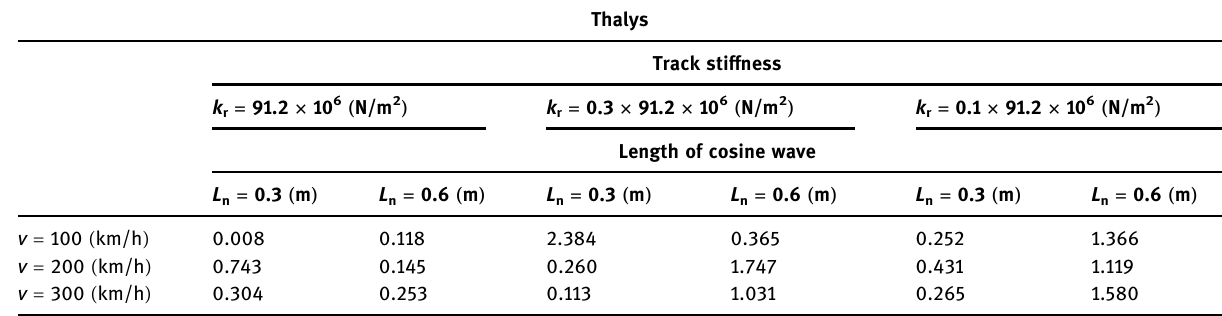
Table 2: The amplitude di ff erences for the two considered models ( Thalys )